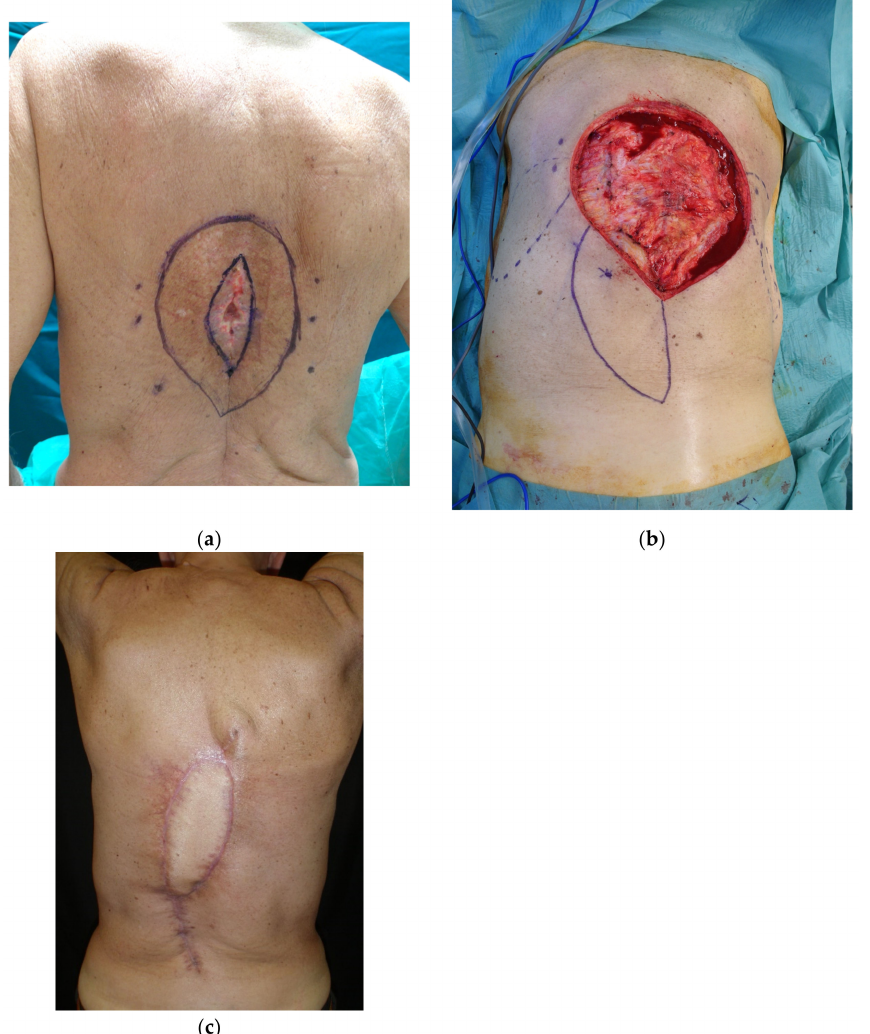
Figure 7. ( a ) Dehiscence after attempt at direct closure in irradiated skin; ( b ) wide margin excision of the compromised skin and design of a propeller flap based on the perforator of posterior intercostal artery; and ( c ) result at one month